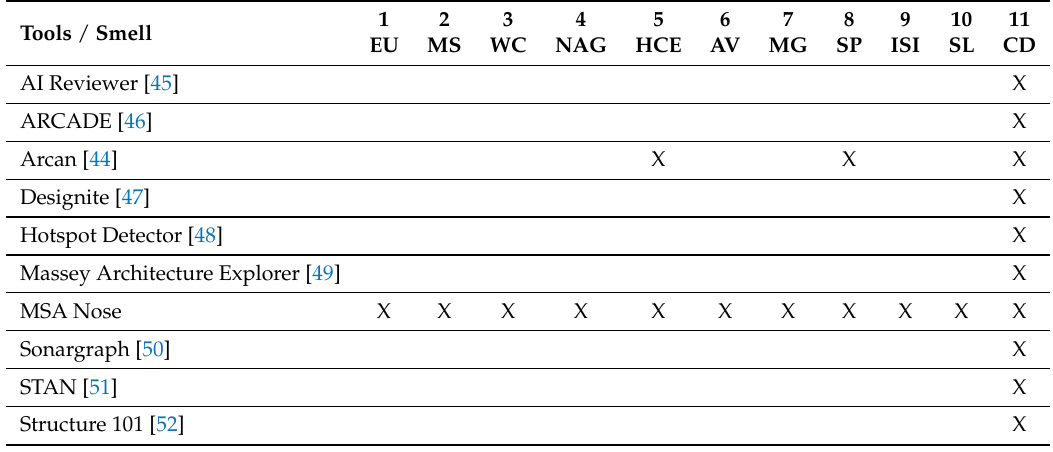
Table 1. Comparison of architectural code smell detection